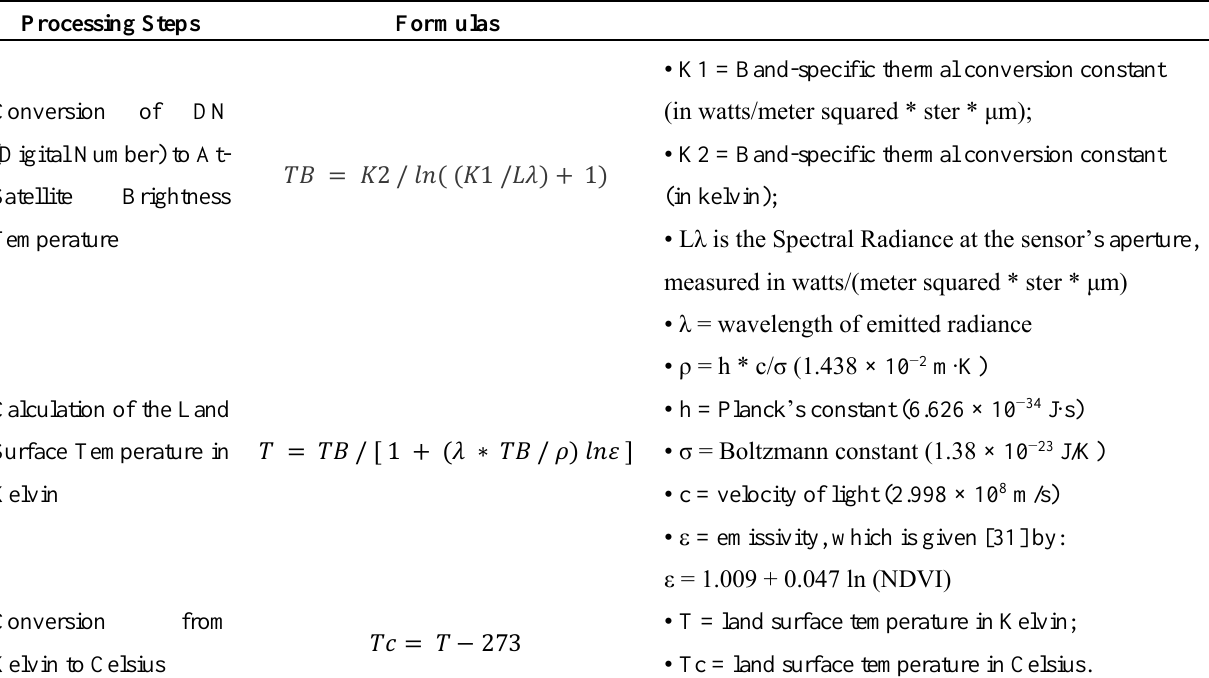
Table 1. Processing steps as well as formulas for the conversion of the DN to